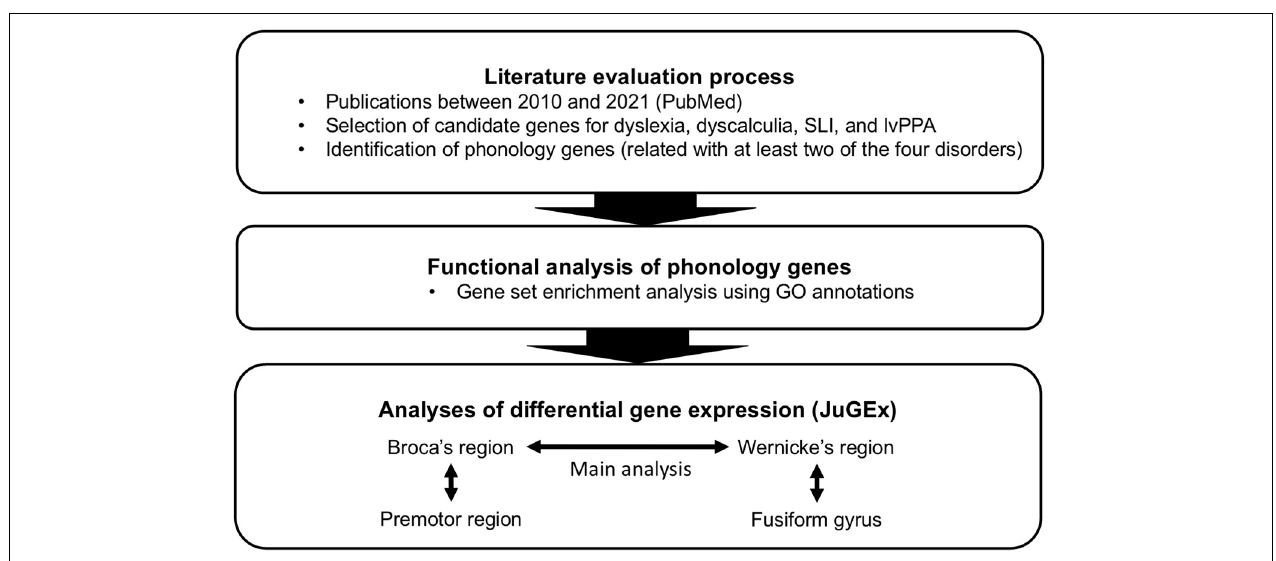
FIGURE 1 | Design of the present